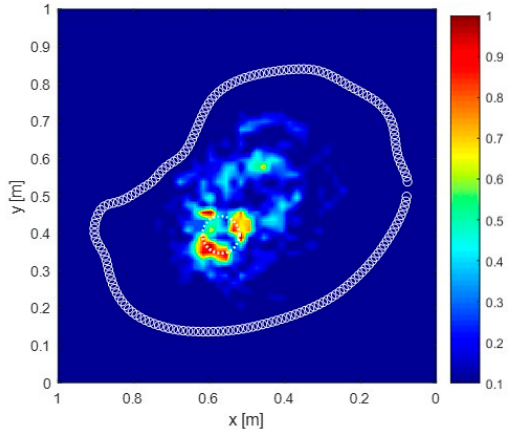
Figure 12. Radargrams of the simulations for the complex-shaped hardwood tree scenario. ( a ) Raw radargam; ( b ) processed radargram after the application of the pre-processing stage.